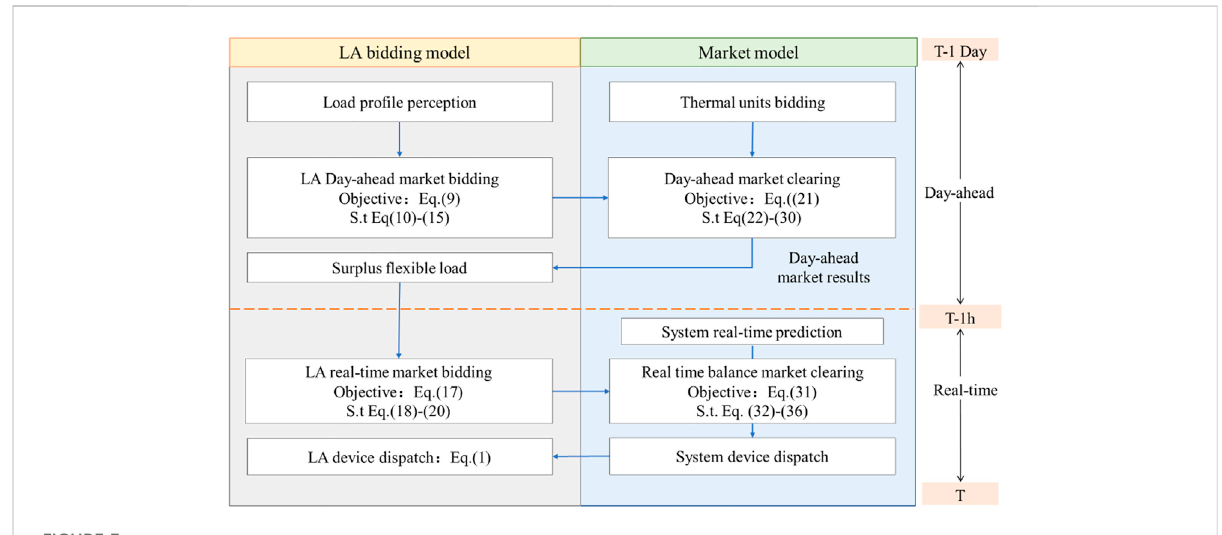
FIGURE 3 The fl owchart for market-bidding and